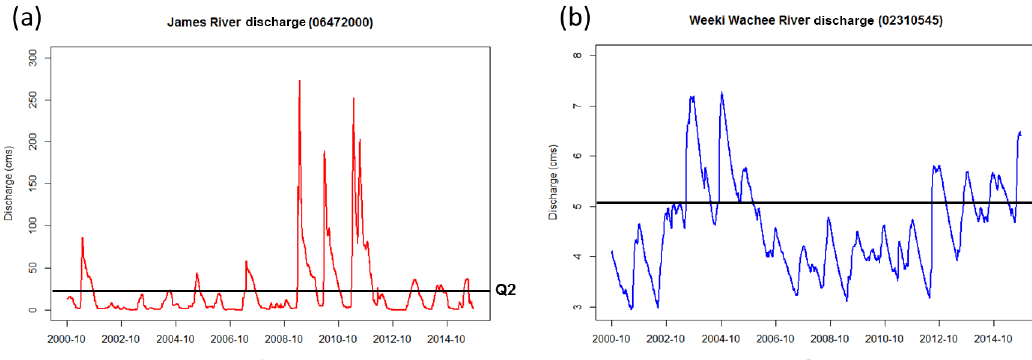
Figure 10. Example sites for event duration concerns.